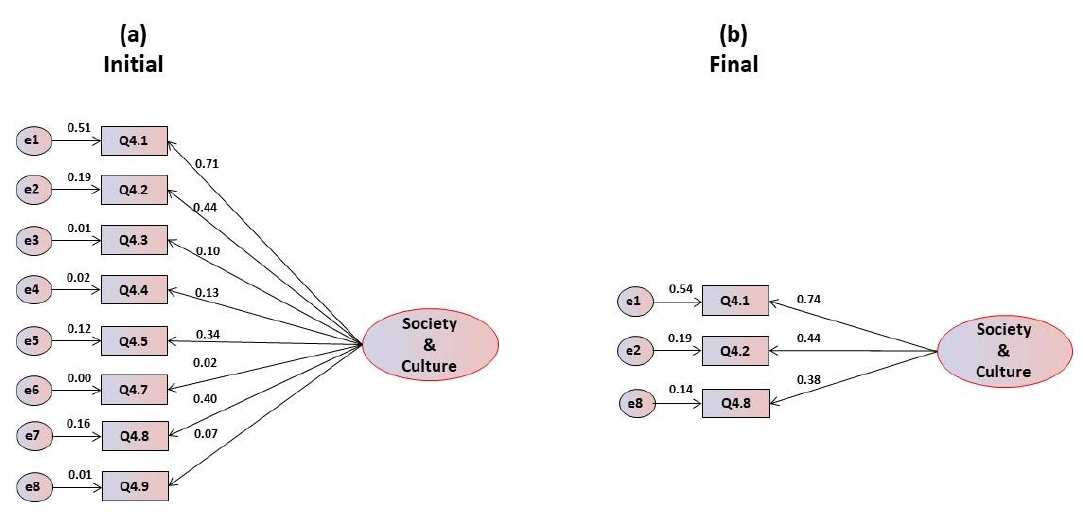
Figure 4. ( a ) Initial and ( b ) final models for the social and cultural motivations’ scale.